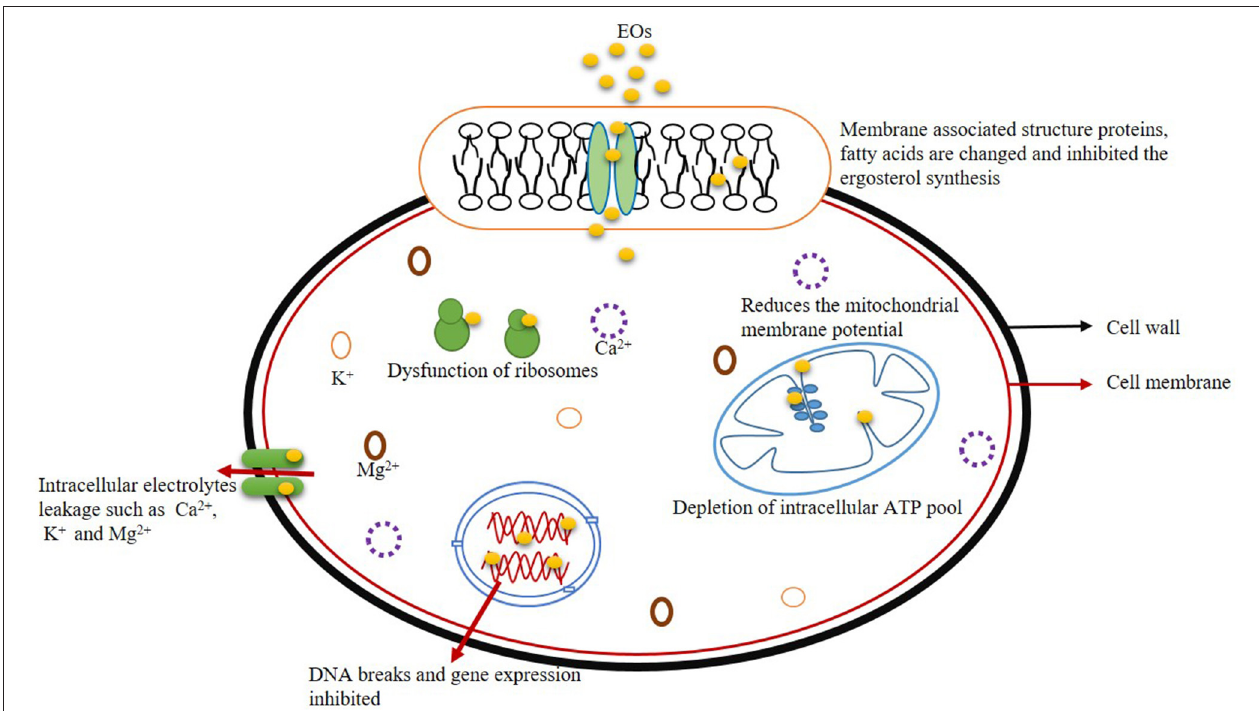
FIGURE 2 | Possible target site for antifungal mechanisms of